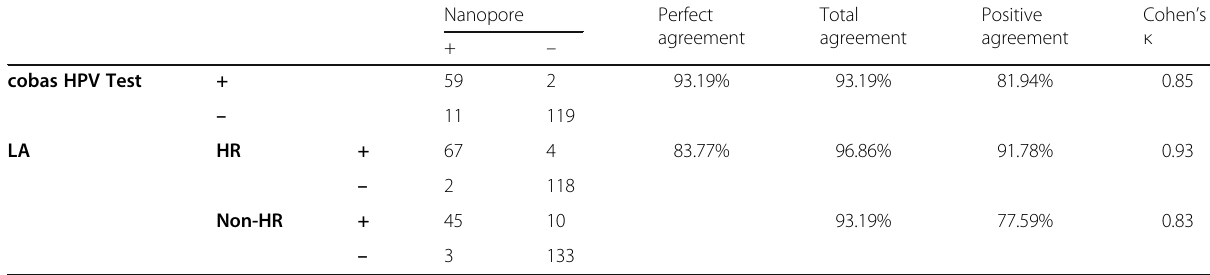
Table 5 Agreement between cobas HPV Test, Roche Linear Array HPV Genotyping Test (LA) and Nanopore